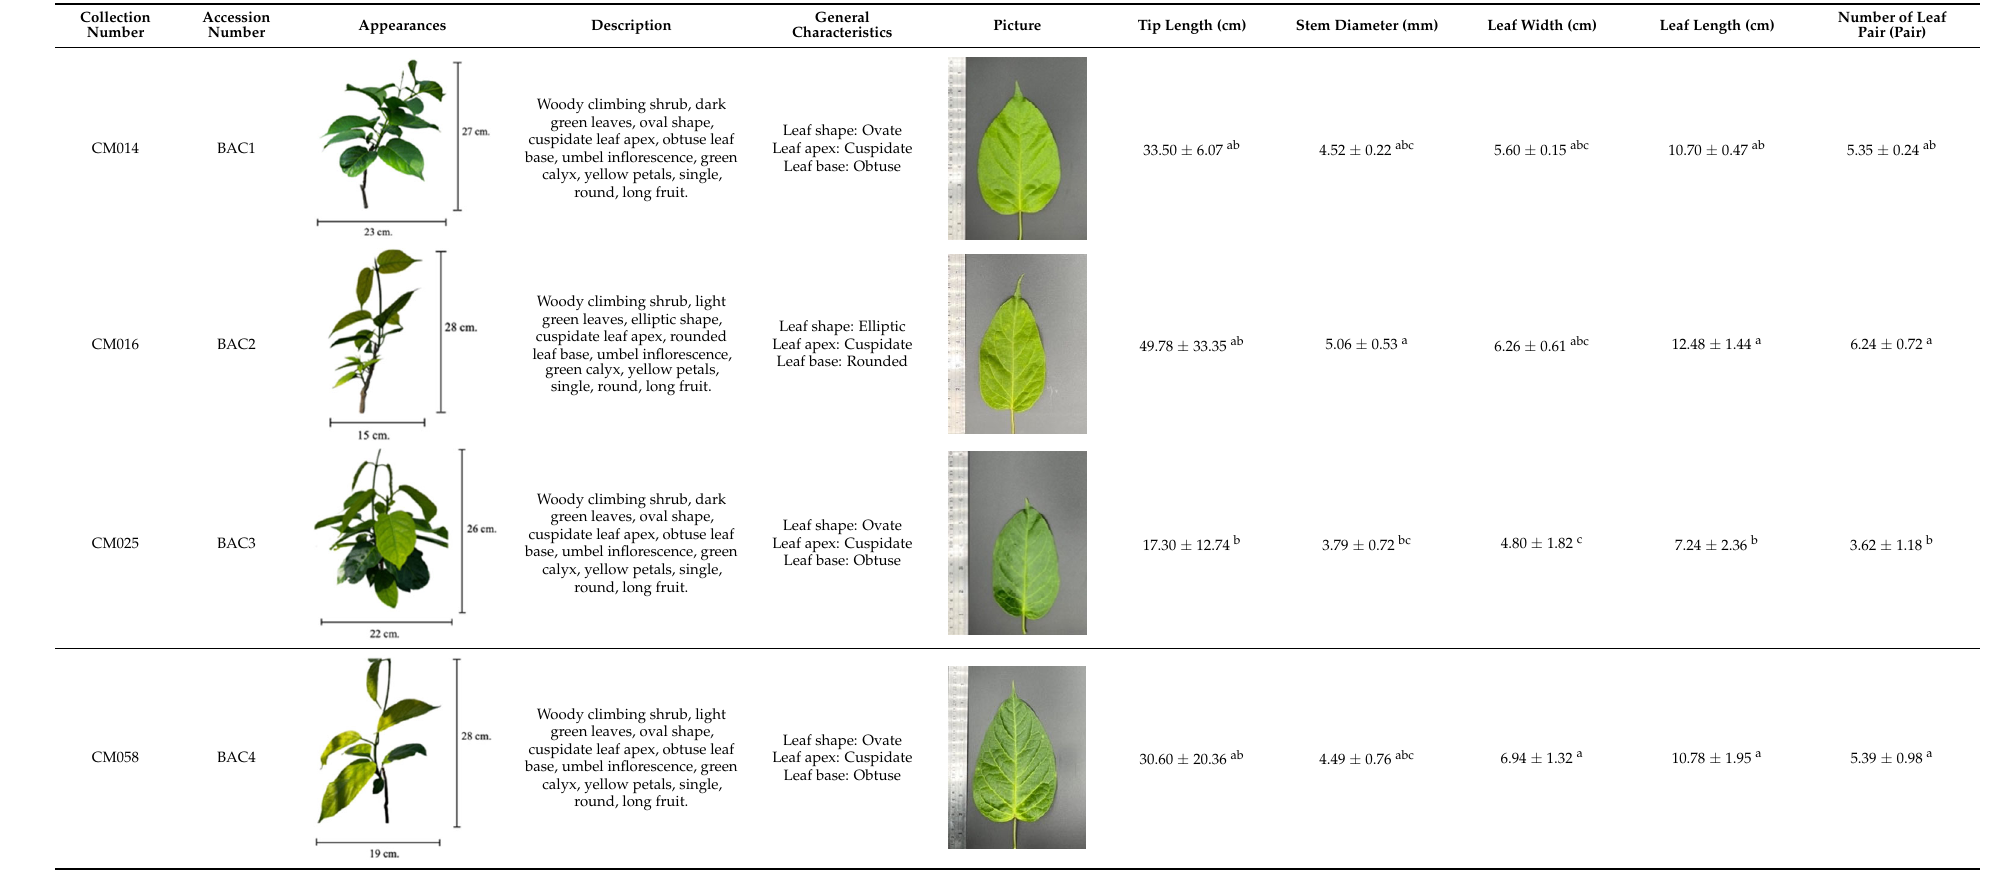
Table 2. Morphological appearances of different Gymnema inodorum lines.